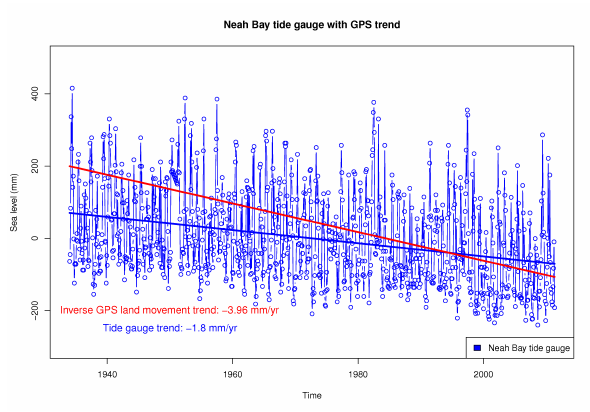
Fig. 7. Height time series and trend for Neah Bay tide gauge and